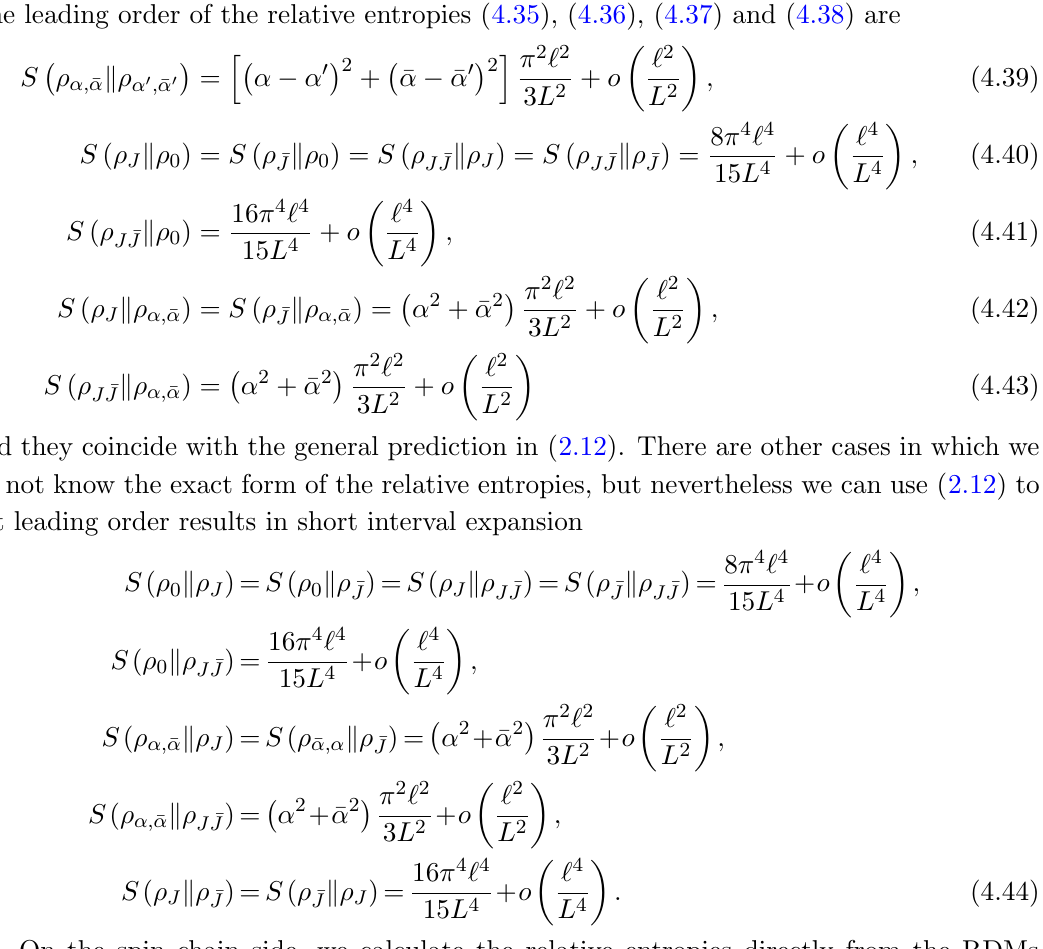
Figure 6 . Relative entropy S ( (cid:26) k (cid:27) ) as a function of the ratio between the subsystem ‘ and the system size L in the free compact boson. Solid lines are the CFT prediction for short distance, eqs. (4.39), (4.40) and (4.42). The symbols joined by dashed lines represent numerical data (obtained using eq. (A.21)), with di(cid:11)erent symbols corresponding to di(cid:11)erent L . Di(cid:11)erent colours correspond to di(cid:11)erent pairs of states (cid:26) and (cid:27) . The leading order of the relative entropies (4.35), (4.36), (4.37) and (4.38)